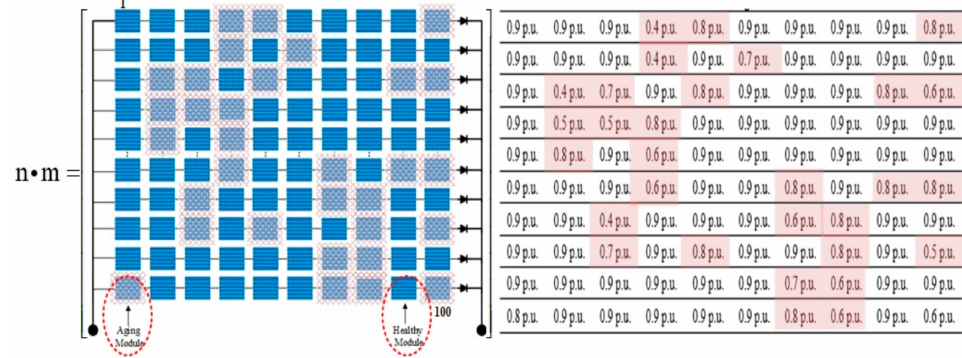
Figure 8. The final step of the reconfiguration algorithm (after arrangement).